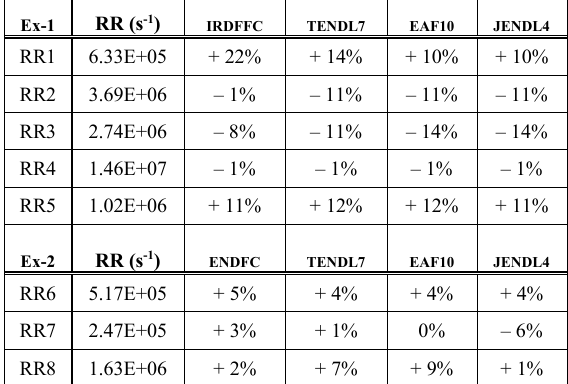
Table 3. Reaction rate (RR) measured for different reactions in experiments 1 (Ex-1) and 2 (Ex-2). In the last four columns, the % deviations of the reaction rates calculated using unfolded spectra (with different input response-functions as shown) from the measured rates are given for their